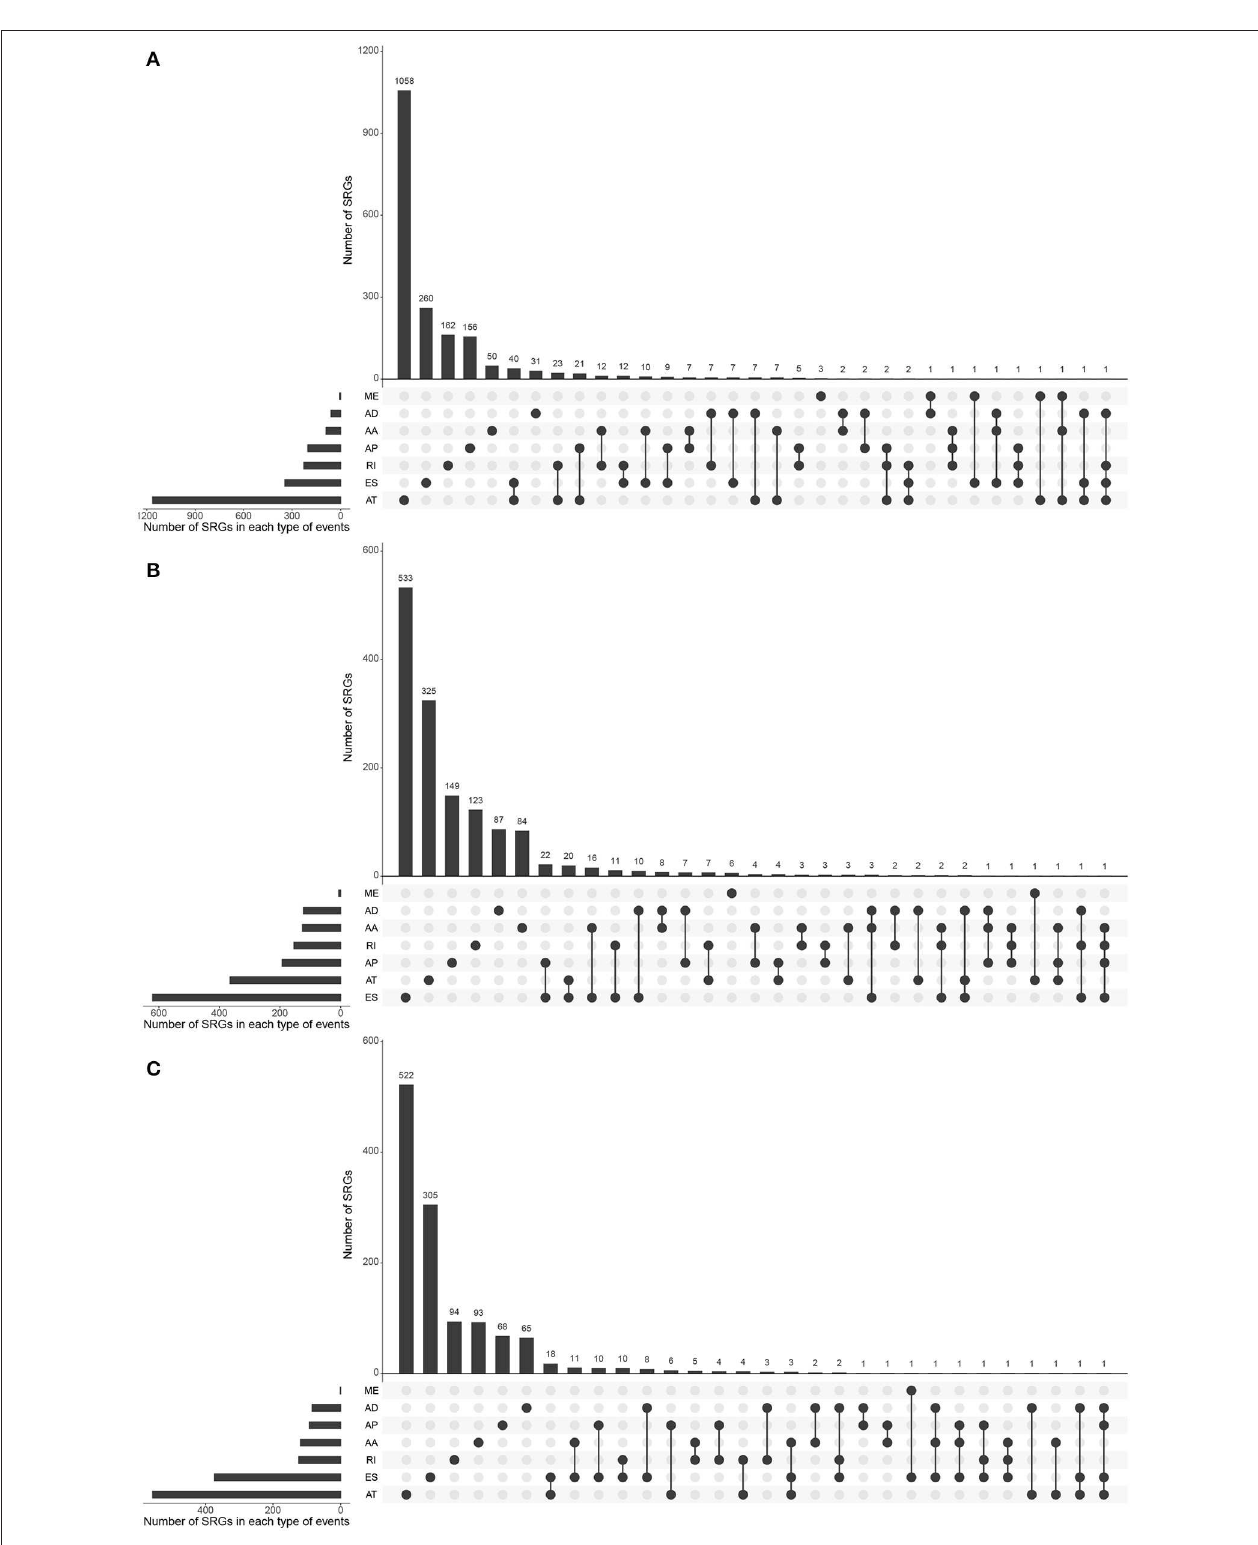
FIGURE 3 | The distributions of SREs and SRGs in each kind of RCC. The strip at the bottom left shows the number of SREs included in each AS type. The dot and line at the bottom right represent the subsets of AS events. The AS types corresponding to dots were contained in the subtype. The number of relevant genes in each subset is represented in the histogram, which is the upper part of the whole plot. (A) KIRC; (B) KICH; and (C) KIRP.